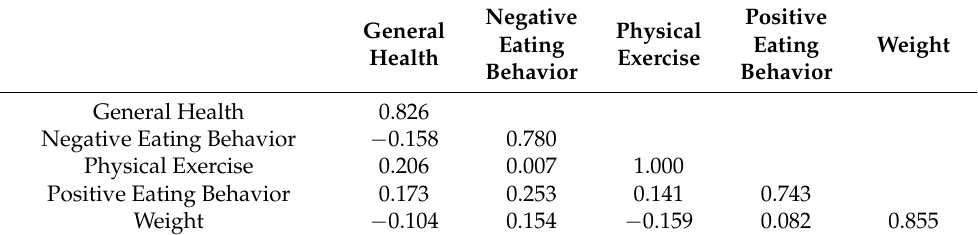
Table 4. Results of the application of the Fornell–Larcker criterion.